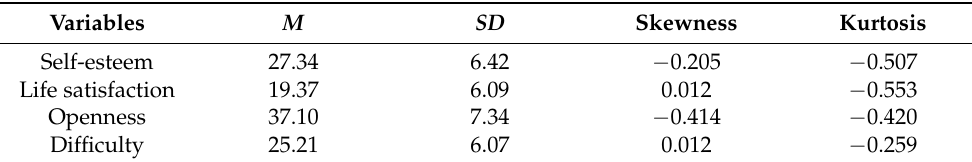
Table 1. Descriptive statistics for self-esteem, life satisfaction, openness, and difficulty in communica- tion ( N =